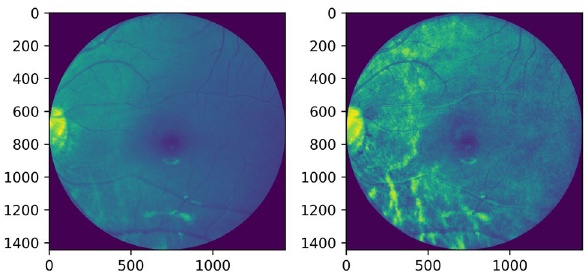
Figure 7. Red channel extracted image and its adaptive histogram equalization.